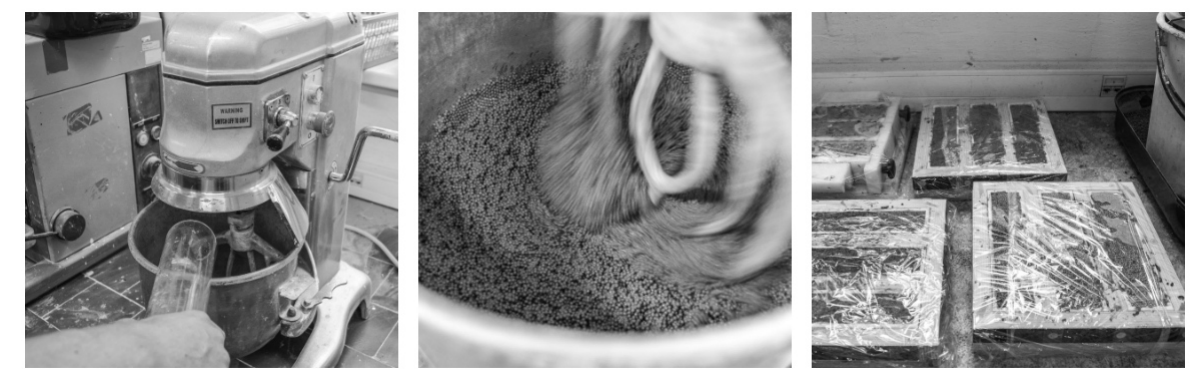
Figure 2. Illustration of manufacture of test